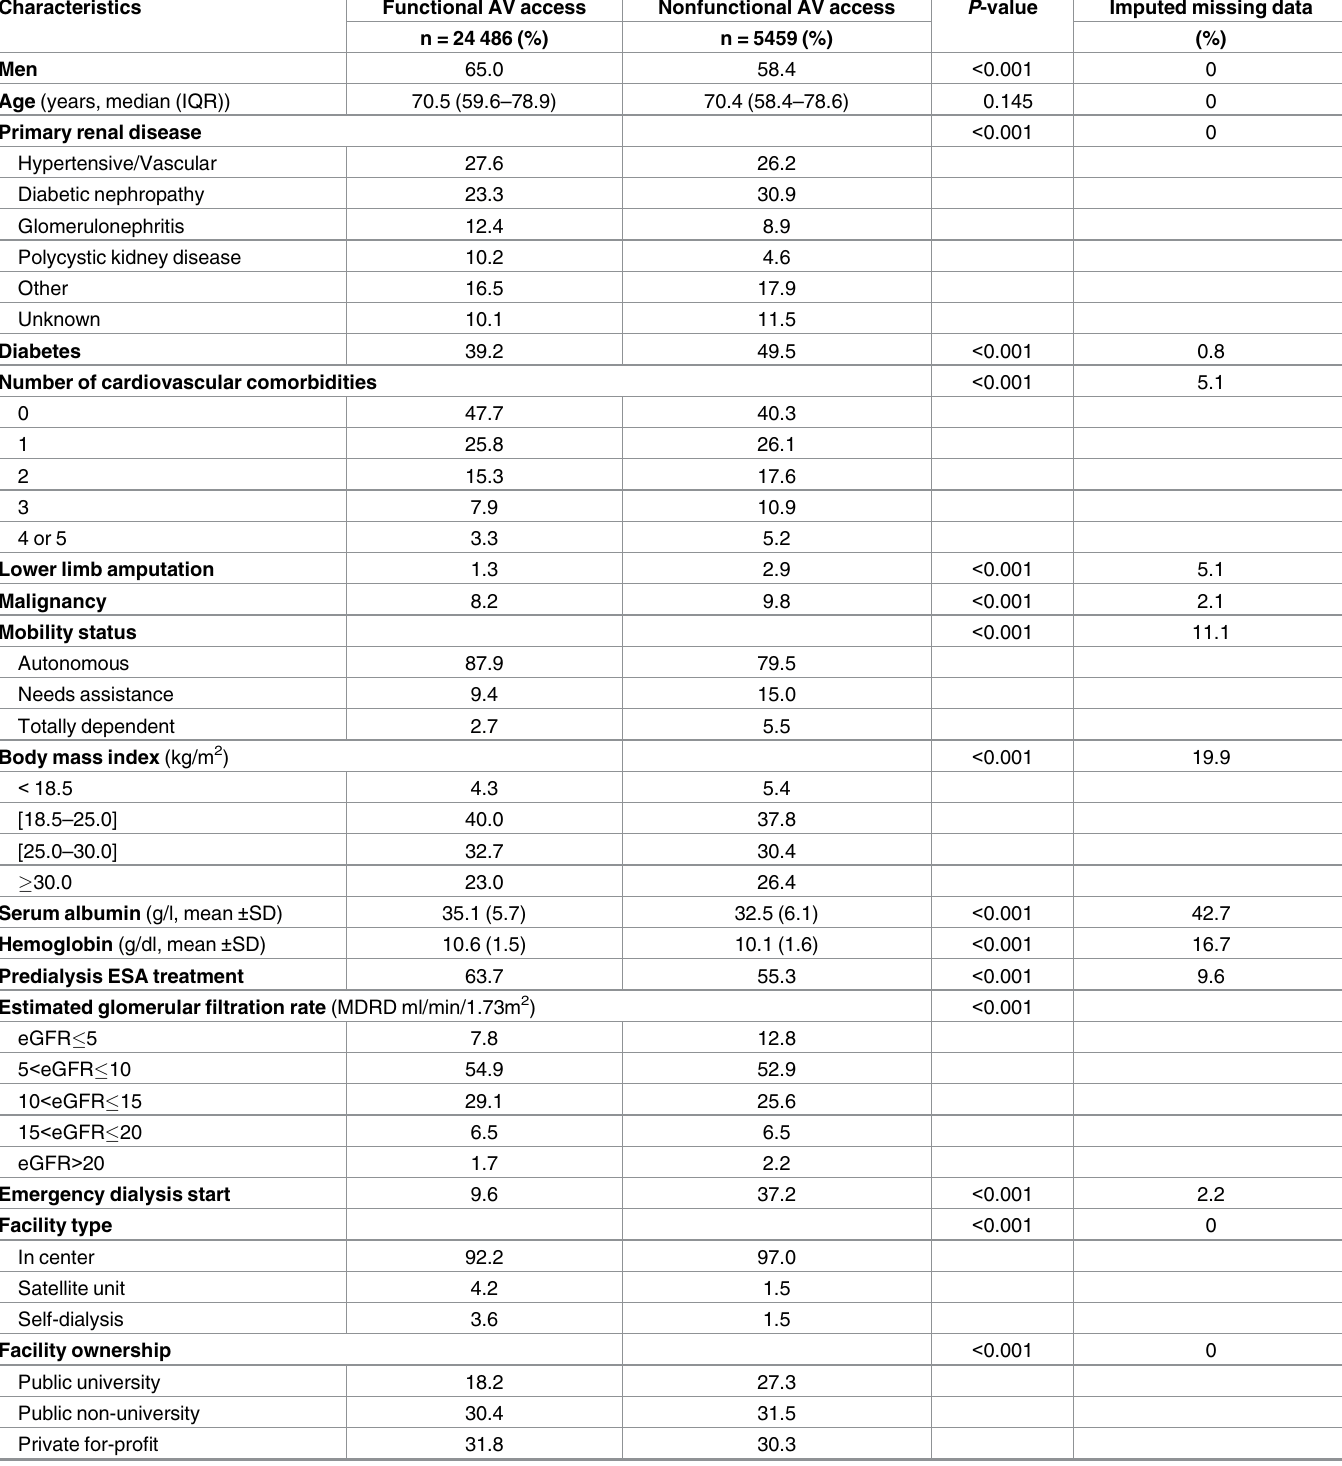
Table 1. Cohort characteristics by arteriovenous accessfunctionality status at hemodialysis